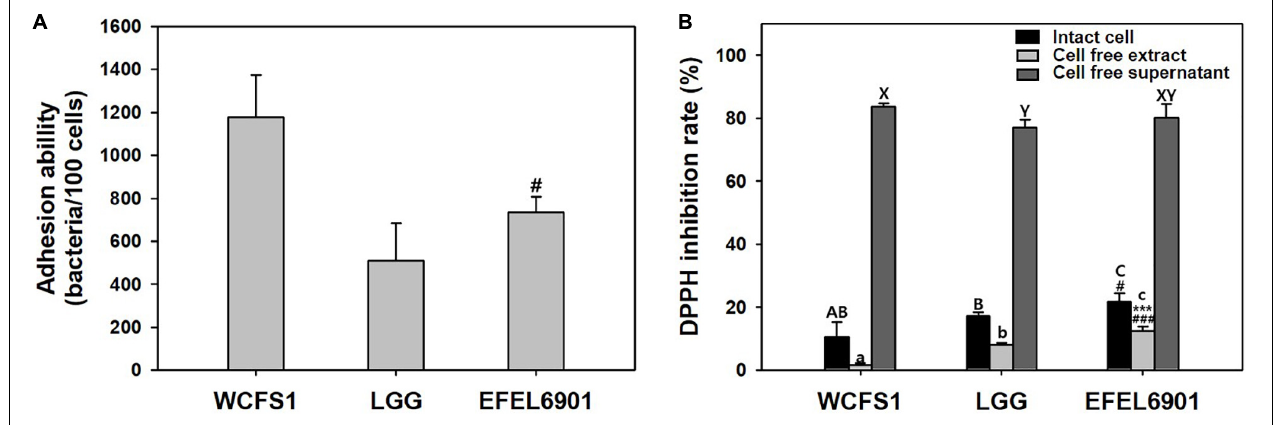
FIGURE 2 | Adhesion ability (A) and antioxidative activity (B) of Limosilactobacillus reuteri EFEL6901. (A) Intestinal adhesion ability of L. reuteri EFEL6901 on HT-29 cells was measured. (B) Antioxidative activity was measured by DPPH inhibition assay. Significant differences are presented with L. plantarum WCFS1 ( # p < 0.05,